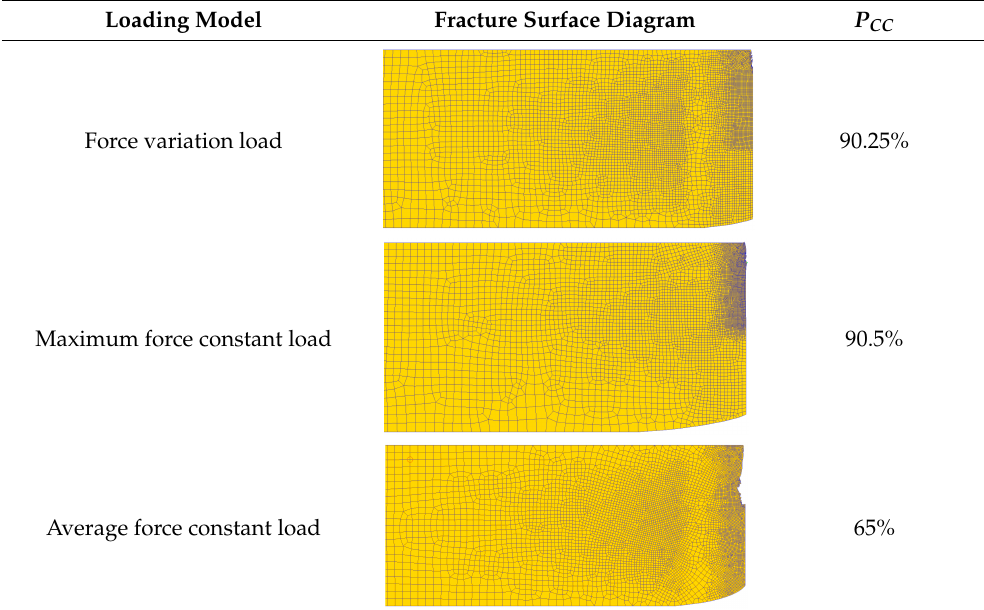
Figure 11. Diagram of loading path and load on the die: ( a ) loading route of blank holder force; ( b ) load on the die. Table 9. Fracture surface quality of the parts.